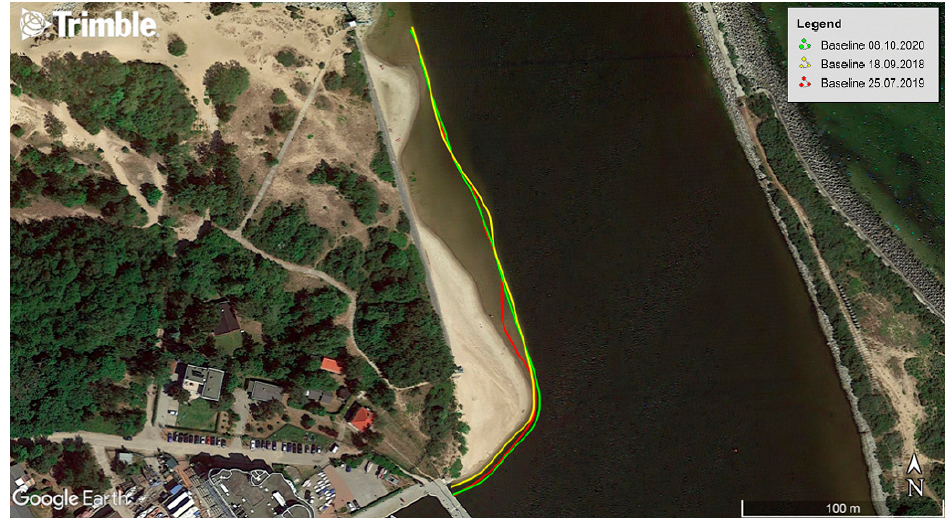
Figure 6. The course of the TSB of the waterbody located close to the Vistula Ś mia ł a River mouth measured with the hydrographic method in 2018–2020.